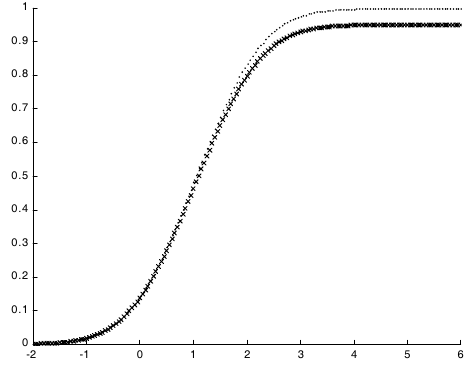
Figure 7 – Prevision of satisfaction relative to Figure 8 – Prevision of satisfaction relative to